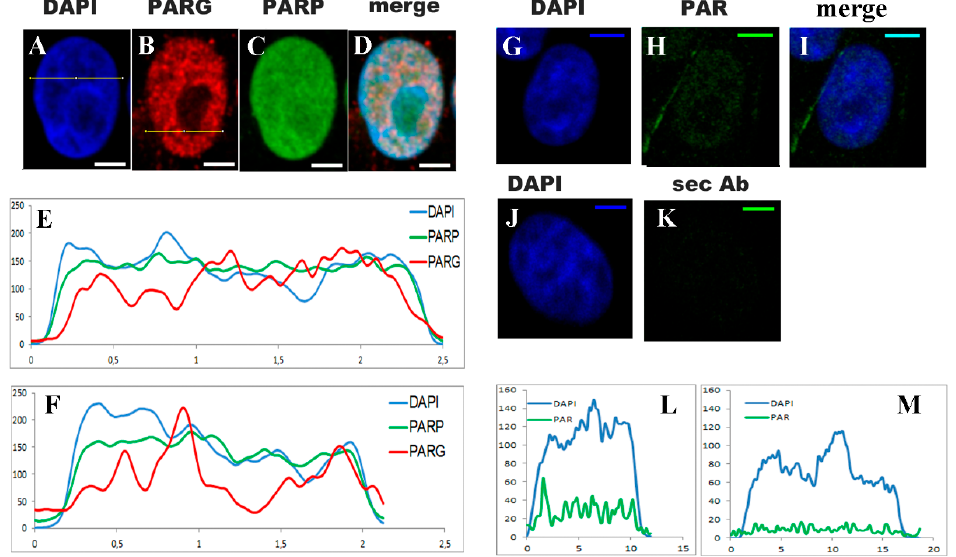
Figure 2. PAR, PARP, and PARG were detected in the VERO cell nuclei. ( A – D ) DAPI (blue), PARG (red), PARP (green), and the merged confocal images of representative nuclei. ( E , F ) Graphs displaying the fluorescence intensity measurements in the three channels of the correspondent nuclei images through two lines that are drawn in ( A ) or ( B ) respectively. Intensity in Relative units. Distance: 1 U ≈ 5 µ m ( G – I ) Indirect immunocytofluorescence (ICF) with BD anti-PAR antibody. DAPI (blue), PAR (green), and merged channels. (J , K ) Control of the anti-PAR ICF without the anti-PAR antibody with only the secondary antibody (sec Ab). ( L , M ) Blue and green channel intensities measured over a line in ( H ) (with anti-PAR) and ( I ) (without anti-PAR), respectively. Confocal images were obtained with the same settings and subject to identical processing adjustments. Relative intensity on the ordinates and distance in µ m on the abscissas. PAR signal (green) was low but detectable in untreated VERO nuclei. Bar: 5 µm.